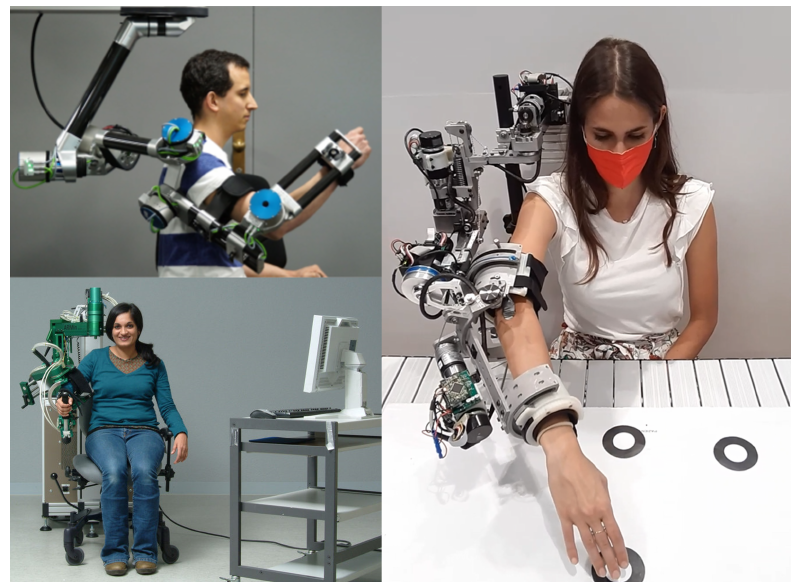
Figure 1. Some examples of upper-limb rehabilitation exoskeletons. The top-left one is ANYexo by ETH Zurich (©2019, Zimmerman et al. from Ref. [2]), the bottom-left one is ARMin (©2010, Nef et al., from Ref. [3]), and the one on the right is AGREE, the prototype from our research group at Politecnico di Milano